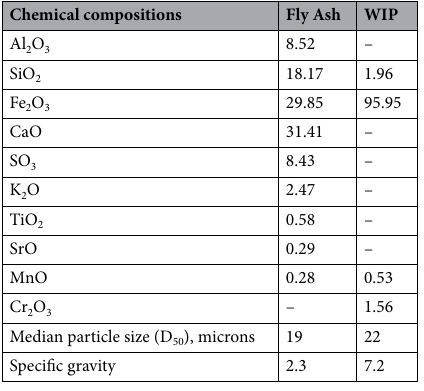
Table 1. Properties and chemical compositions of